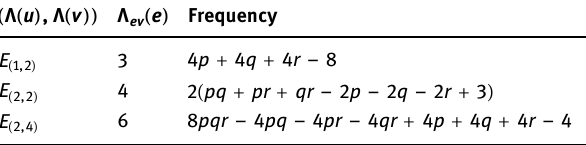
Table 1: The edges ev - degree of Cu O 2